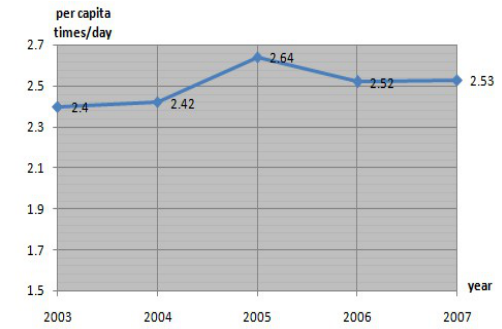
Fig. 2. Number of trips per capita per day in Beijing (2003-2007) metropolitans (See Table 4.), especially London.